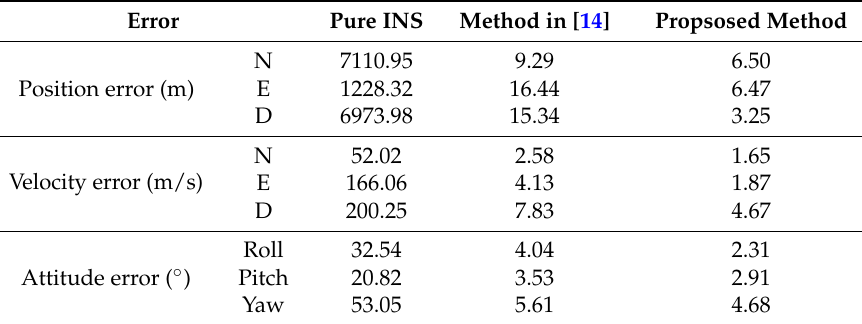
Figure 11. Position error of the experiment. Table 6. RMS navigation parameter error of the experiment.